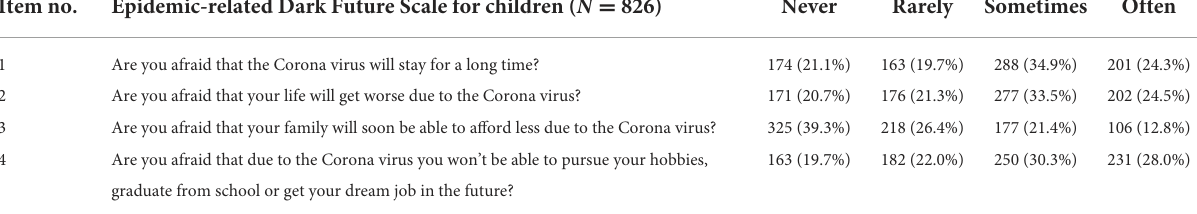
TABLE 2 Results of the epidemic-related Dark Future Scale for children (eDFS-K). Item